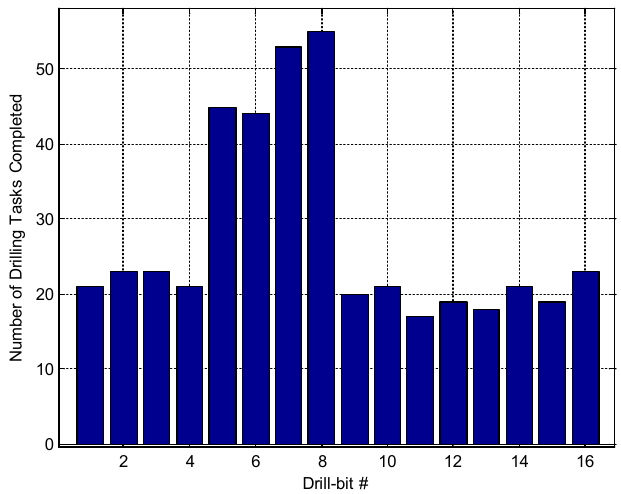
Figure 3. x -axis: Drill-bit # is an unique identification number for each drill-bit used in the experiment. There are total of 16 drill-bits so they are marked as 1 – 16 accordingly. y -axis: total number of drilling tasks completed for each of the 16 drill-bit in the experiment.